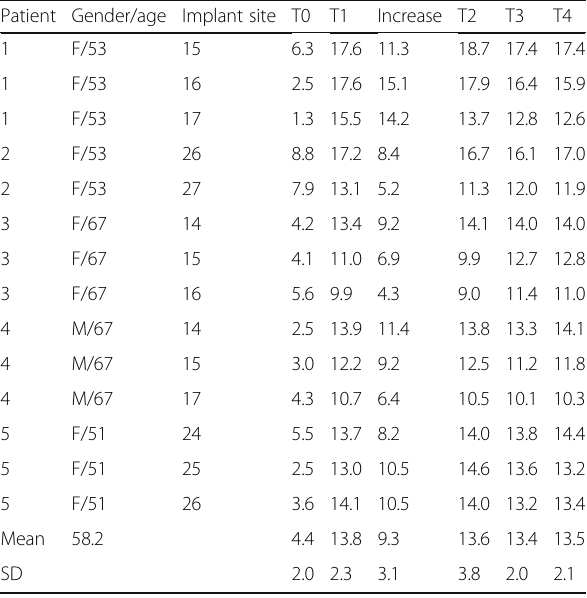
Table 2 Radiological results (alveolar tissue height measurements in true mm) in the 12-month group Patient Gender/age Implant site T0 T1 Increase T2